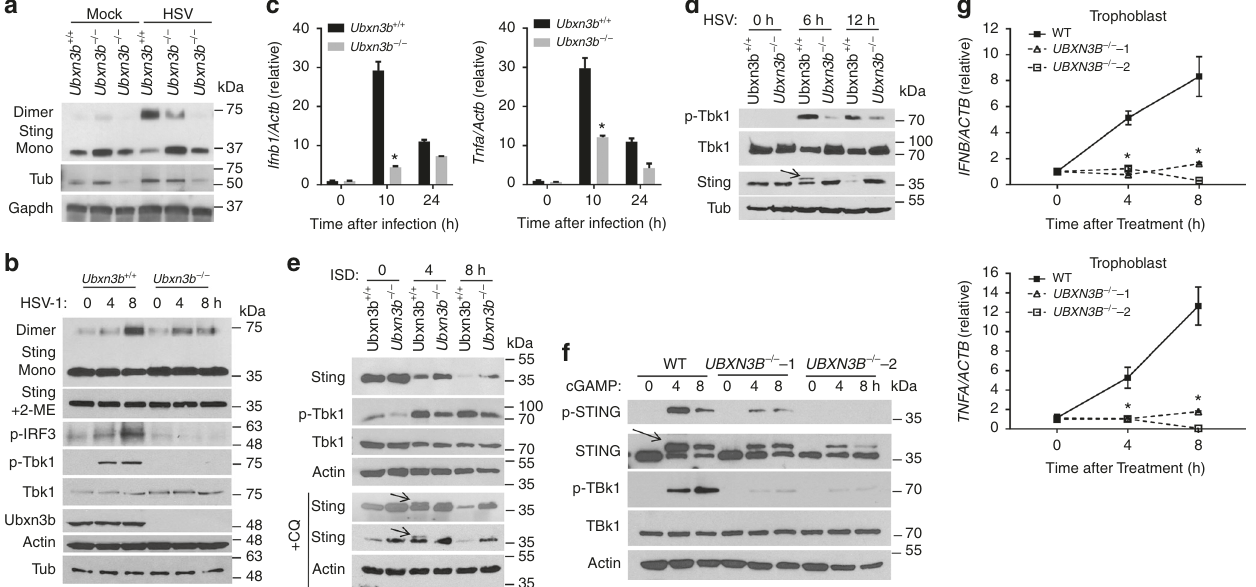
Fig. 4 UBXN3B regulates STING dimerization, phosphorylation, and degradation. a Immunoblots showing Sting dimerization in untreated ( Ubxn3b + / + ) and 4-hydroxyl tamoxifen-induced Cre + / − Ubxn3b fl ox/ fl ox ( Ubxn3b − / − ) primary MEFs. The cells were infected without (mock) or with HSV-1 (MOI = 0.5) for 8 h. b Immunoblotting analysis of the whole-cell lysates of bone marrow-derived cDCs infected with HSV-1 (MOI = 5). Mono monomer, 2-ME β -mercaptoethanol, a chemical compound that reduces disul fi de bonds. c qPCR quanti fi cation of Ifnb1 and Tnfa mRNA induction in cDCs by HSV-1 (MOI = 5). Bars: mean ± s.e.m. Two biological replicates were pooled for qPCR ( N = 2 per genotype per time point). * P < 0.05 (unpaired Student ’ s t test). d – f Immunoblotting analysis of the whole-cell lysates of d MEFs infected with HSV-1 (MOI = 0.5), e MEFs transfected with ISD (8 µ g/ml) in the absence or presence of 40 µ M of chloroquine ( + CQ) and f trophoblasts transfected with cGAMP (8 µ g/ml). In e , f , the arrows indicate phosphorylated STING with long and short exposure. Actin, Tubulin (Tub), and GAPDH are housekeeping protein controls. g qPCR quanti fi cation of IFNB1 and TNFA mRNA induction in trophoblasts transfected with cGAMP (8 µ g/ml). In c , g , the bars are: mean ± s.e.m. Two biological replicates were pooled for qPCR ( N = 2 per genotype per time point). * P < 0.05 (unpaired Student ’ s t test). The results are representative of two to three independent